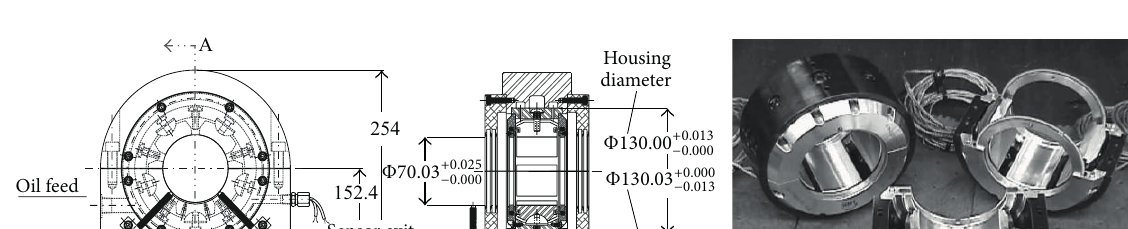
Figure 6: Rotor assembly in the test rig [11].